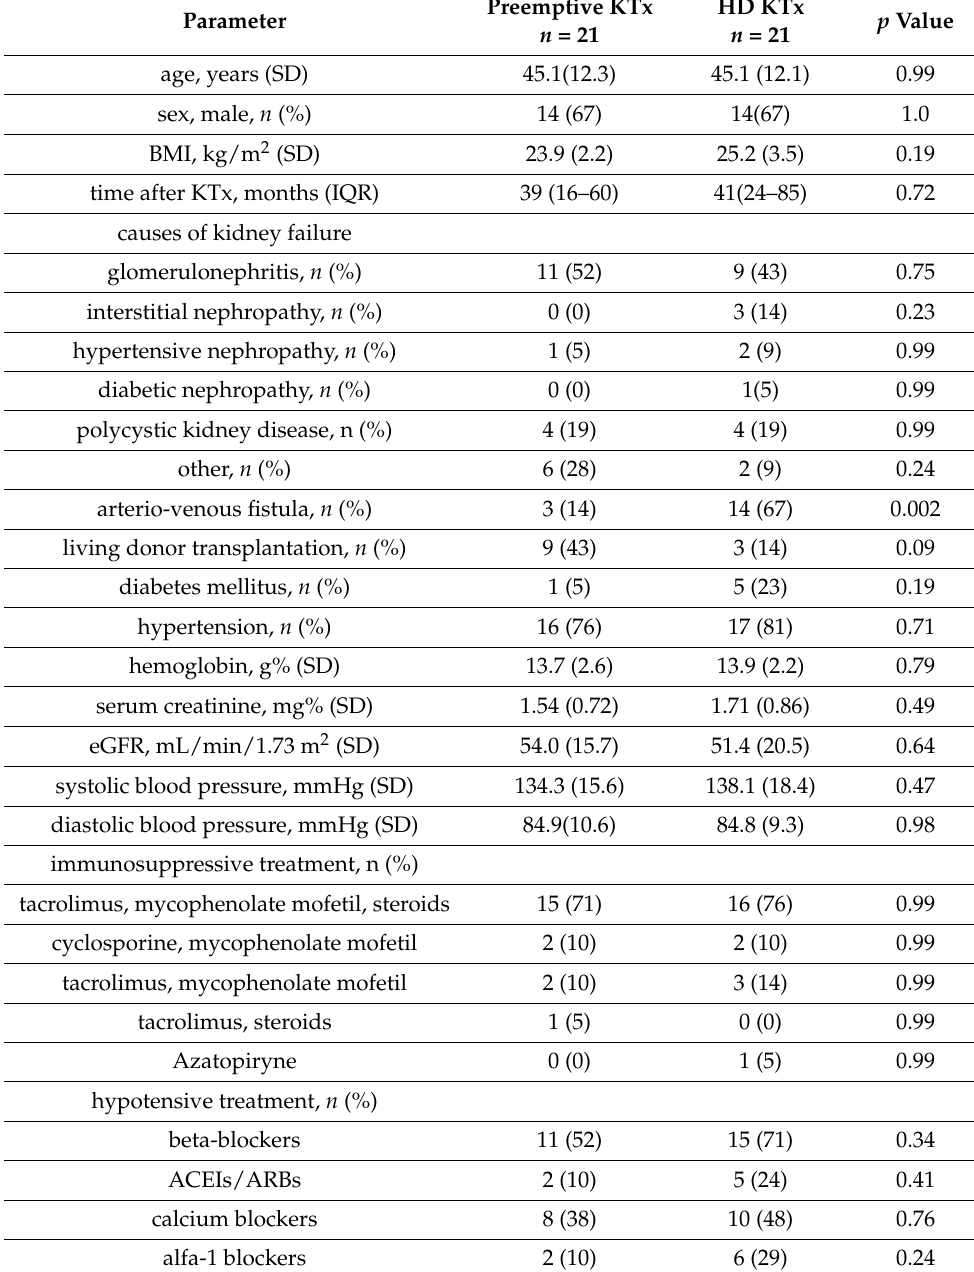
Table 1. Demographic, clinical, and laboratory characteristics of the studied